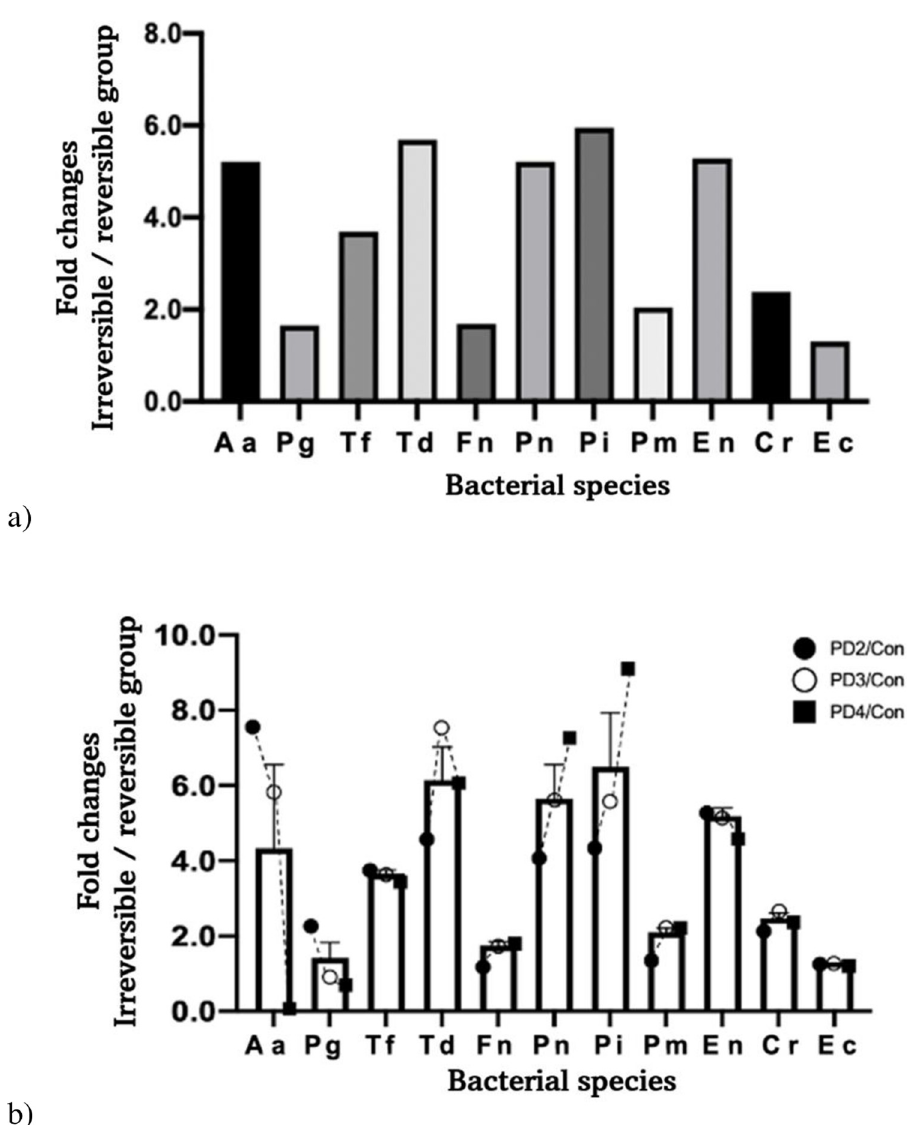
Fig 3. Prevalence of bacteria in comparison between groups. (A) Comparison of fold changes between the reversible and irreversible groups.. (B) Comparison of fold changes between the reversible group and each periodontal disease (PD) group of the irreversible group. PD2: PD2 group, PD3: PD3 group, PD4: PD4 group, con: Reversible